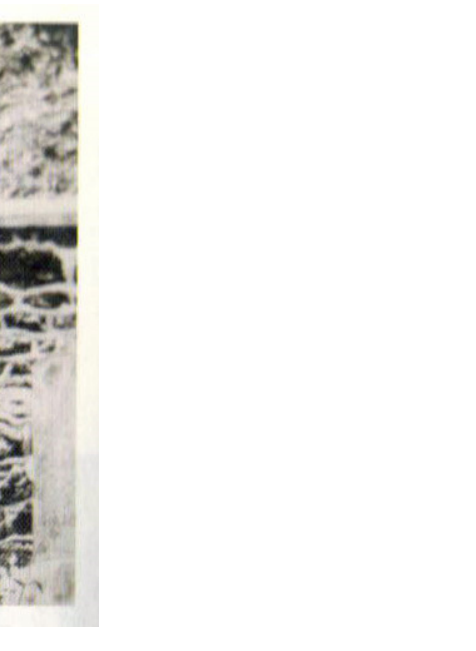
Figure 1. Stele at the initial church entrance [source: Father Kang Do-Young’s Collection of Letters , p. 568].